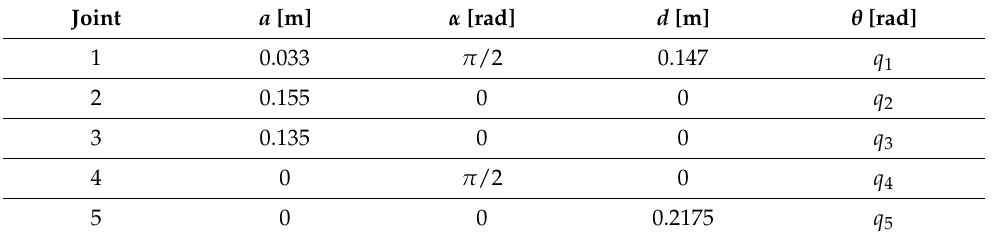
Table 1. DH table for KUKA Youbot manipulator.